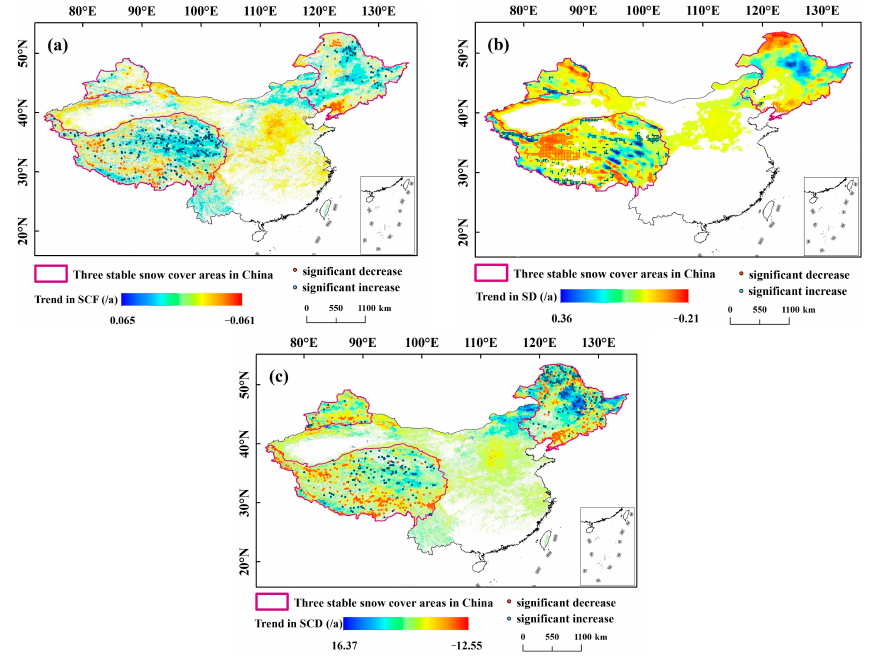
Figure 6. Spatial distribution of variation ratios and the significance of SCF ( a ), SD ( b ), and SCDs ( c ) in the TP, NX, and NC from 2001 to 2019 or 2020.